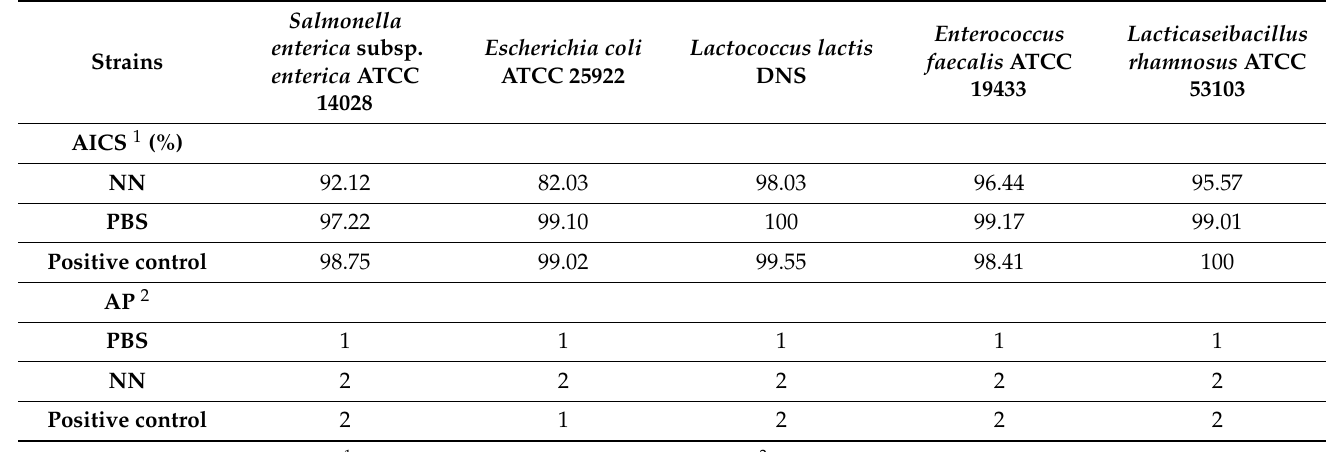
Table 6. The anti-adherence activity of NN sample at different concentrations.